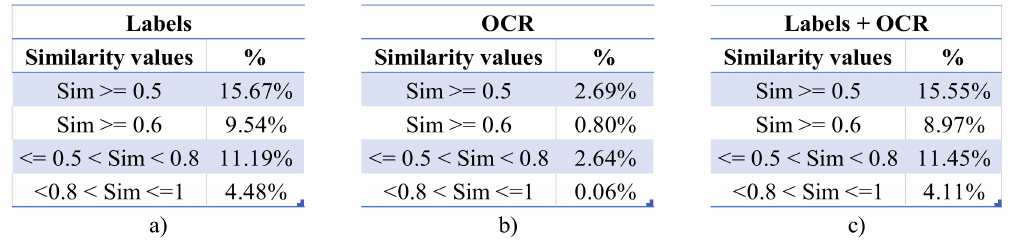
1 (high level similarity) respectively.